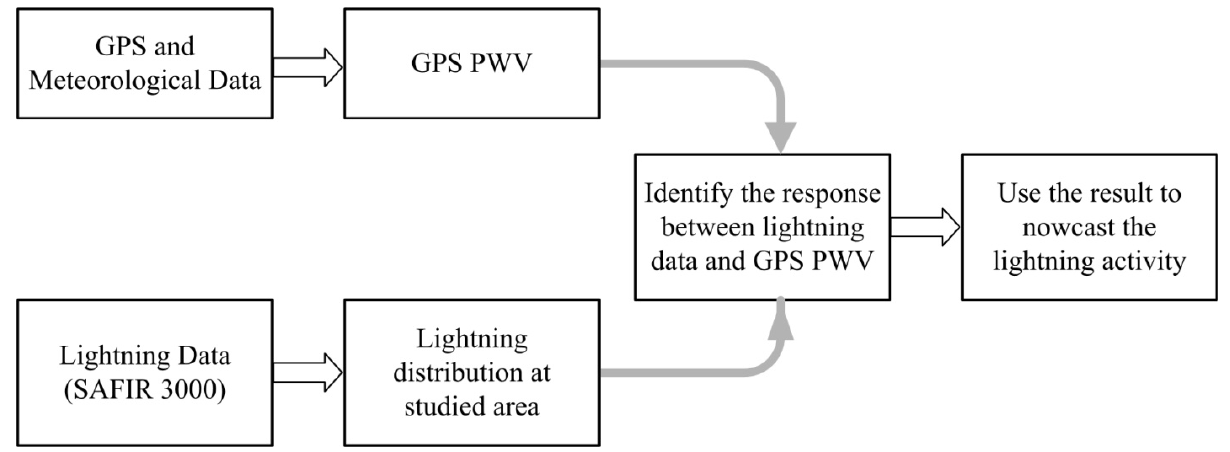
Figure 3. Summary of the processing